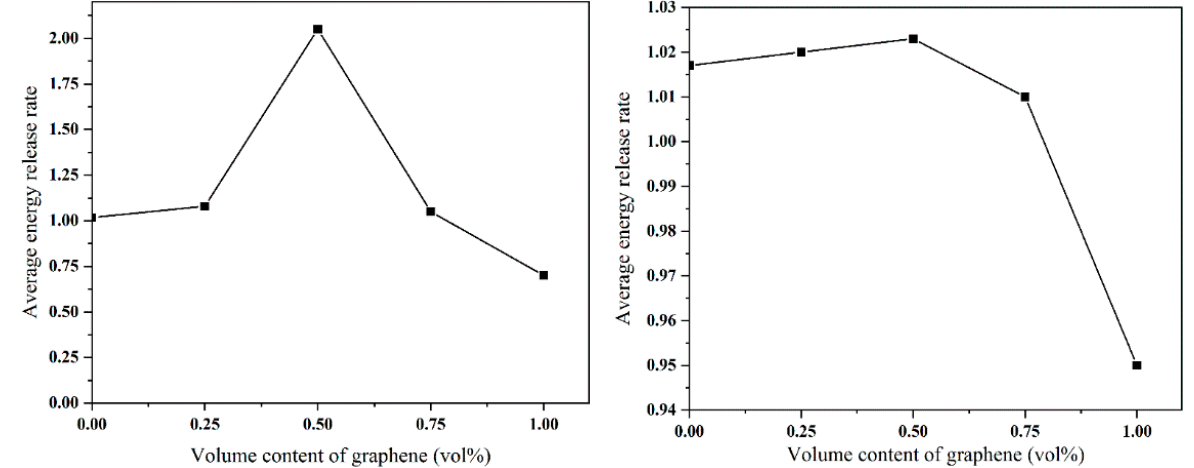
Figure 5. The average energy release rate varies with the volume content of graphene. Table 6. The calculation results of crack propagation under different graphene volume contents.